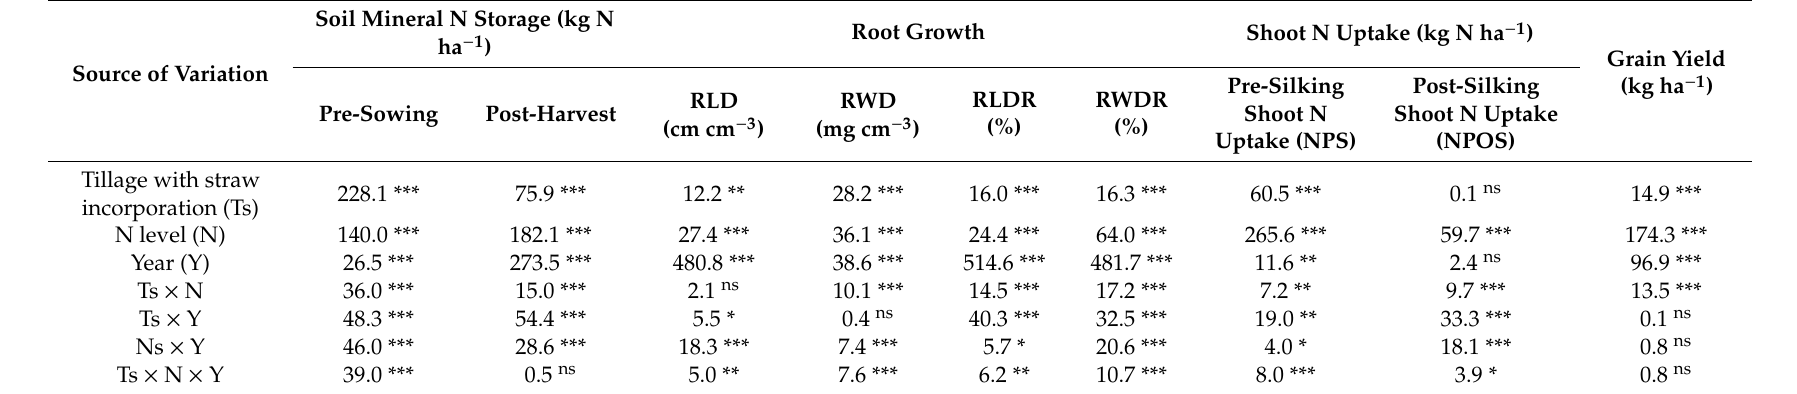
Table 1. ANOVA of tillage with straw incorporation, N level, and year for soil mineral N storage, root length density (RLD), root weight density (RWD), ratio of